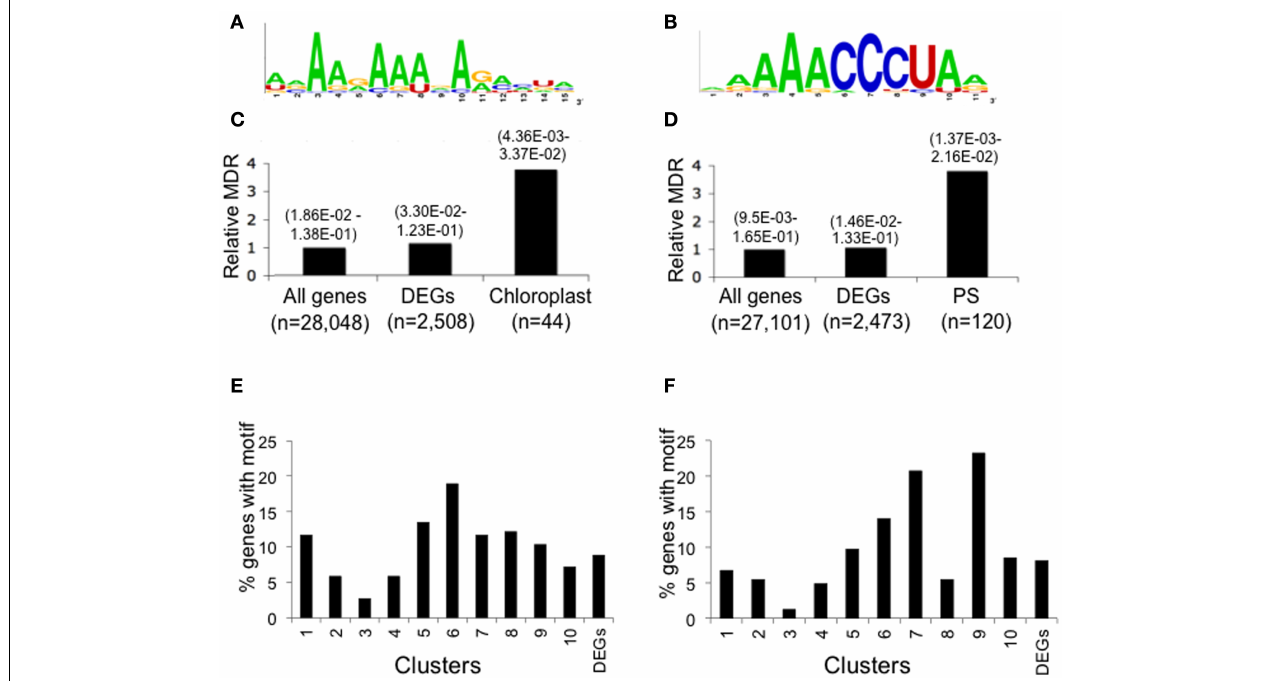
FIGURE 8 | 5 (cid:2) - and 3 (cid:2) -UTR over-represented motifs of dark stabilized and translationally repressed chloroplast and protein synthesis machinery (PS) mRNAs identified by the unsupervised motif finder MEME. Forty-four chloroplast mRNAs from Cluster 6 and 120 ribosomal protein and translation factor mRNAs from Clusters 6–9 were independently analyzed for over-represented sequences.This identified a consensus sequence present in the 3 (cid:2) -UTR of dark-regulated and translationally repressed mRNA encoding proteins targeted to the chloroplast (A) and a consensus motif present in the 5 (cid:2) -UTR of ribosomal protein and translation factor mRNAs that contains the a